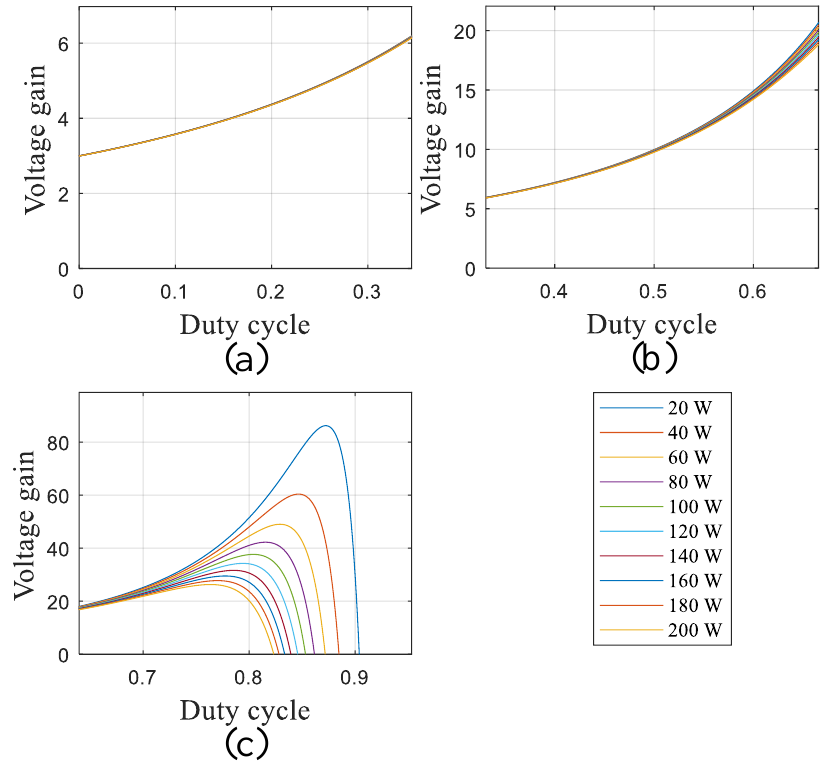
Figure 7. The voltage gain comparing the various output powers as the duty cycle varies from ( a ) 0 to 33%, ( b ) 33% to 66%, ( c ) and 66% to